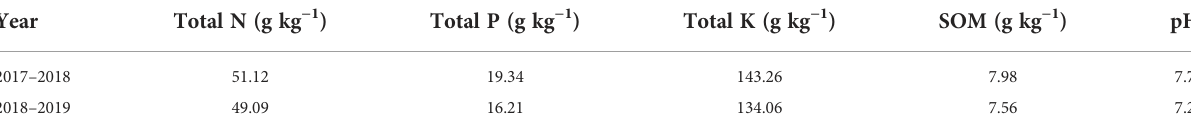
TABLE 1 Soil properties prior to the experiments at the farming station of Shanxi Agricultural University.